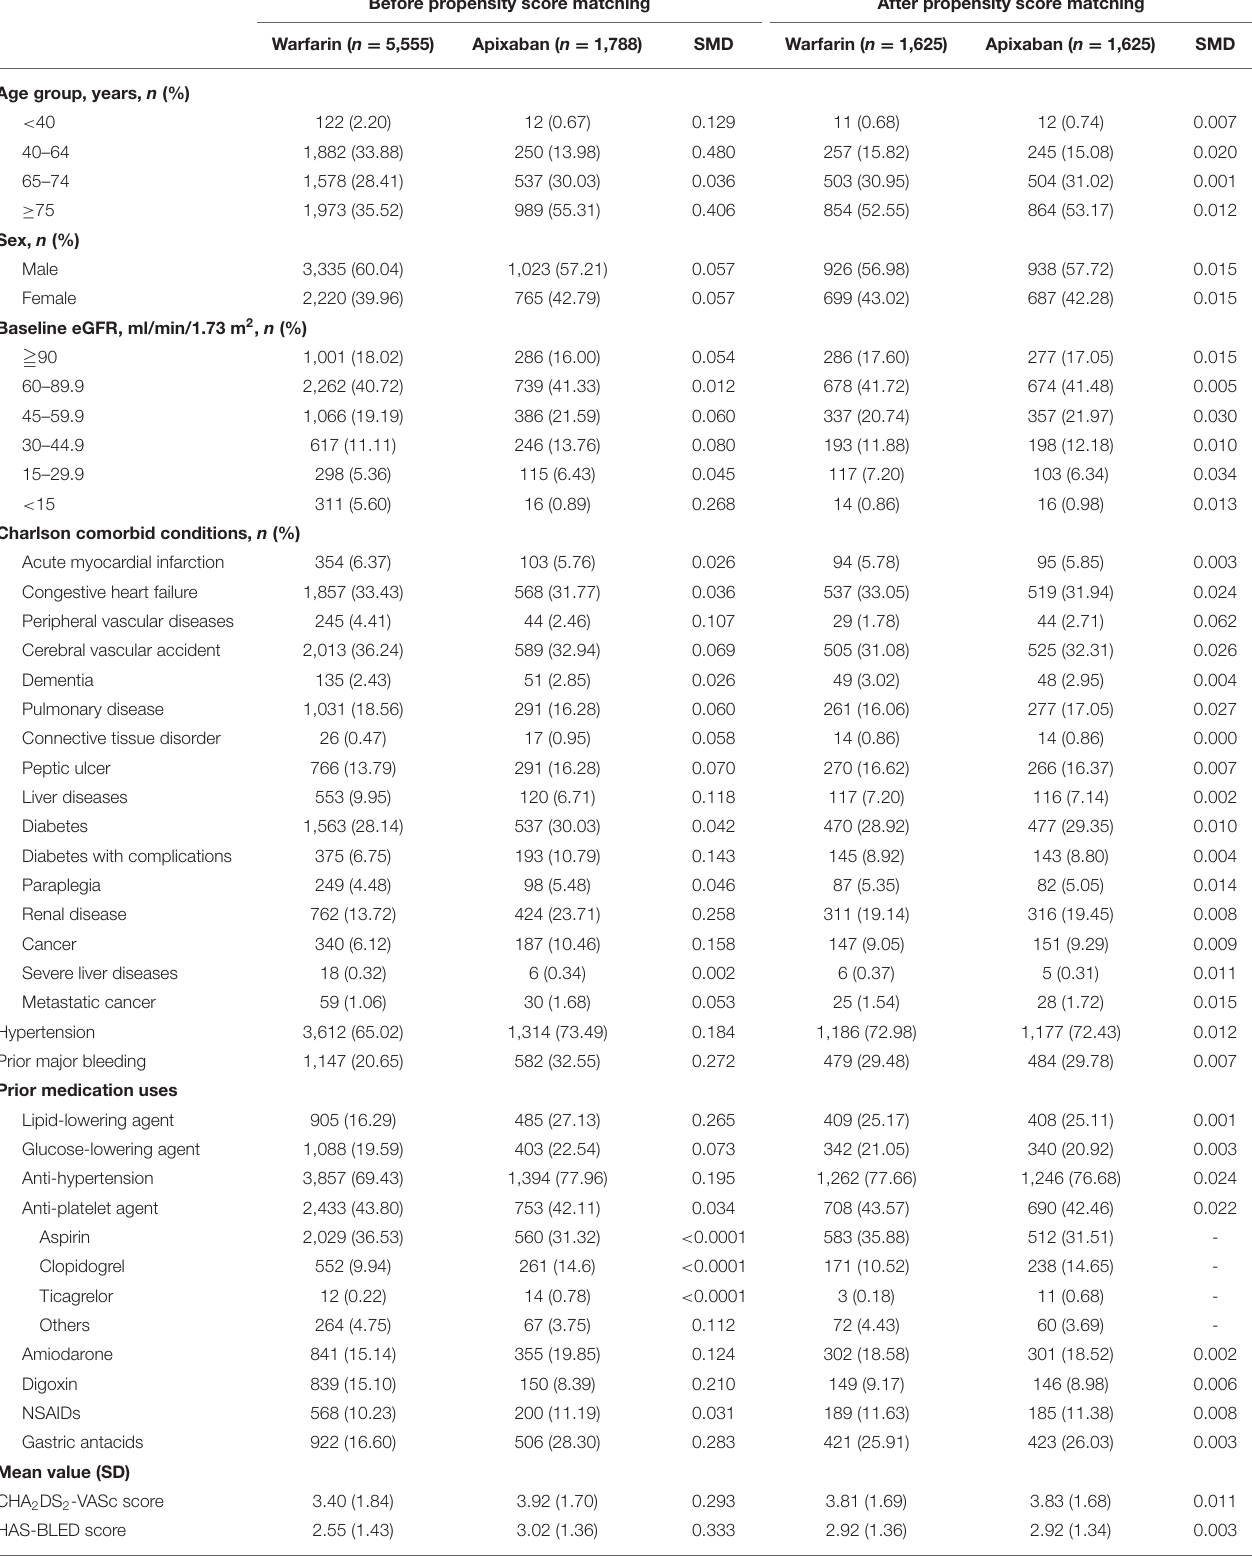
TABLE 1 | Baseline patient characteristics by treatment group before and after propensity score